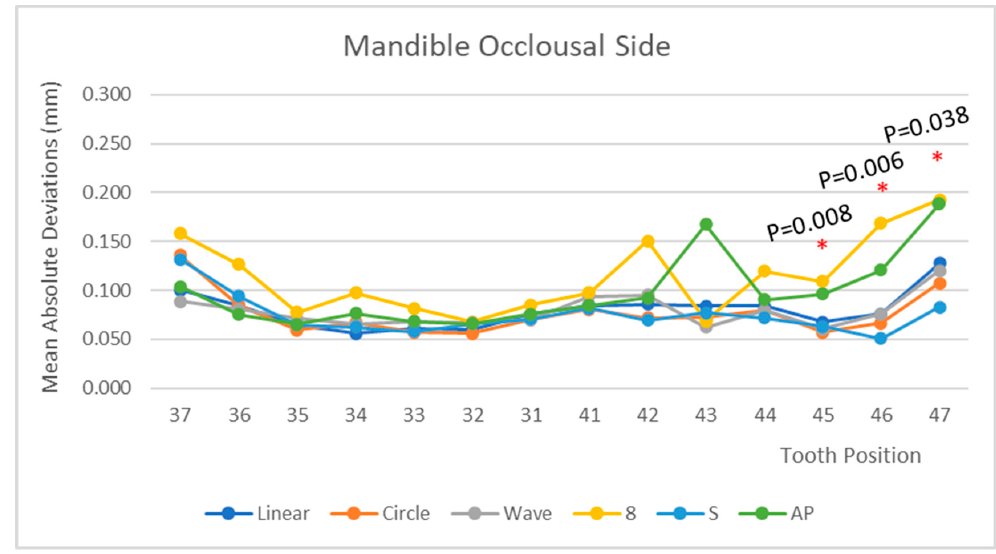
Figure 4. Occlusal deviations at different tooth positions among six head movements in the maxilla. * Statistically different at tooth position among six movements.